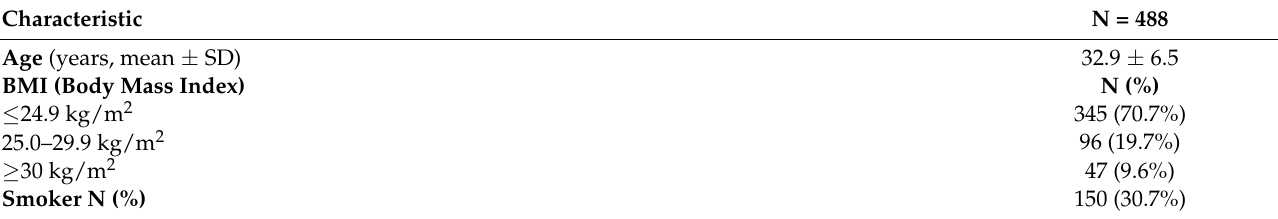
Table 1. Patients’ characteristics at baseline (N =